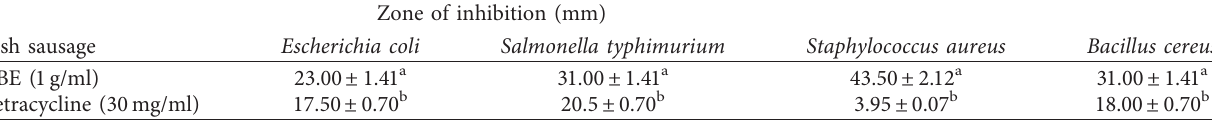
Table 4: The antibacterial activity of bee bread extract (BBE) against foodborne pathogens.